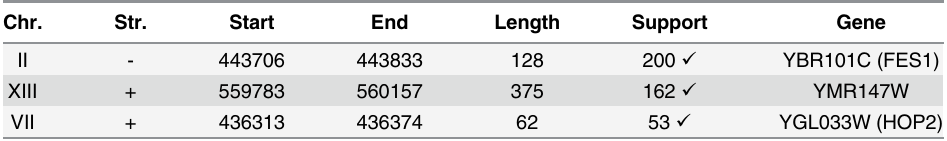
Table 6. Novel introns containing the annotated stop codon. Chr. Str.